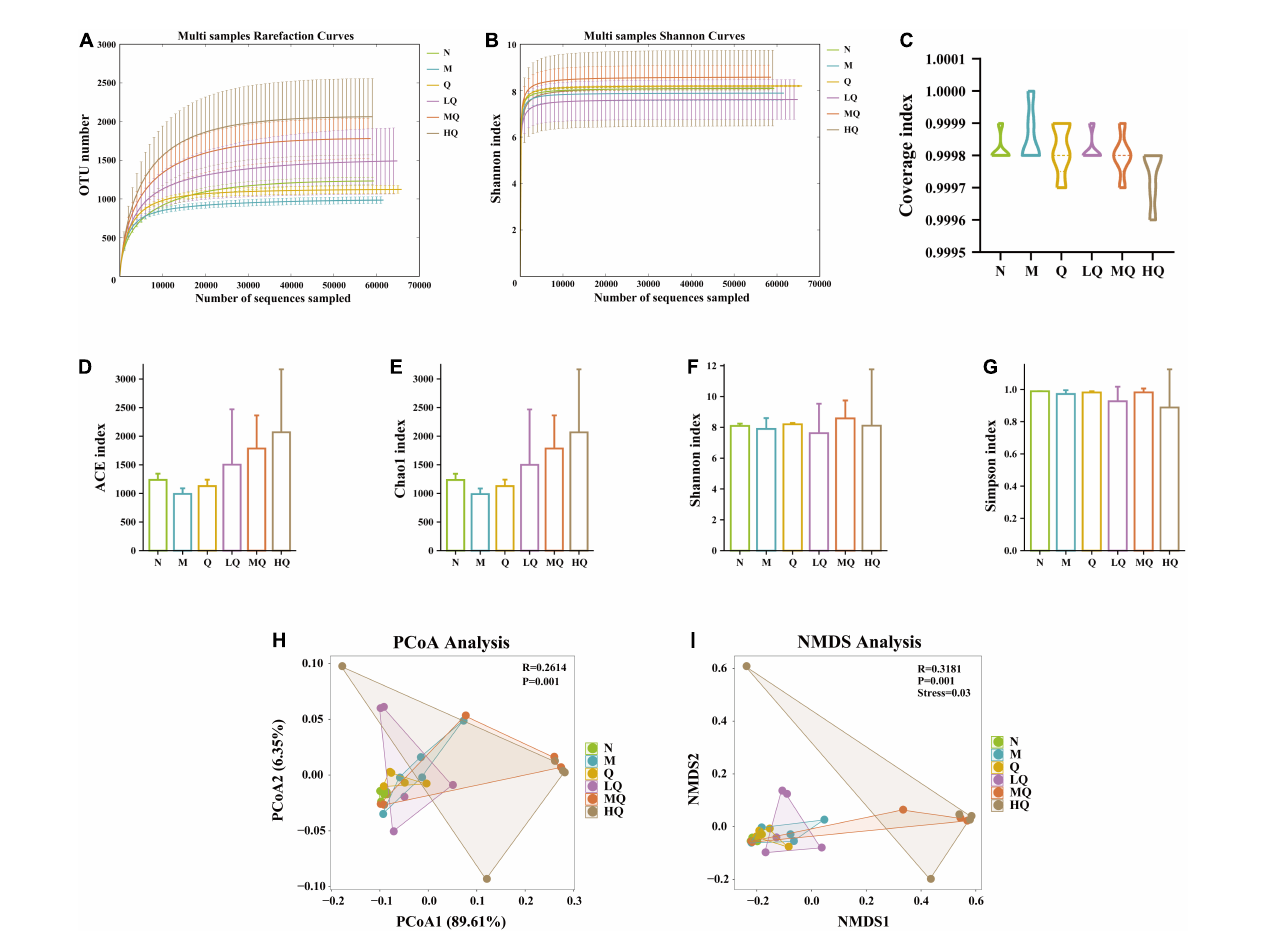
FIGURE4 Effect of different sucrose dose on the alpha diversity and beta diversity of mice with antibiotic-associated diarrhea (AAD) intervened by Qiweibaizhu powder (QWBZP). (A) Rarefaction curve; (B) Shannon–Wiener curve; (C) Coverage index; (D) ACE index; (E) Chao1 index; (F) Simpson index; (G) Shannon index; (H) Principal co-ordinates analysis (PCoA) analysis; (I) Non-metric multi-dimensional scaling (NMDS)